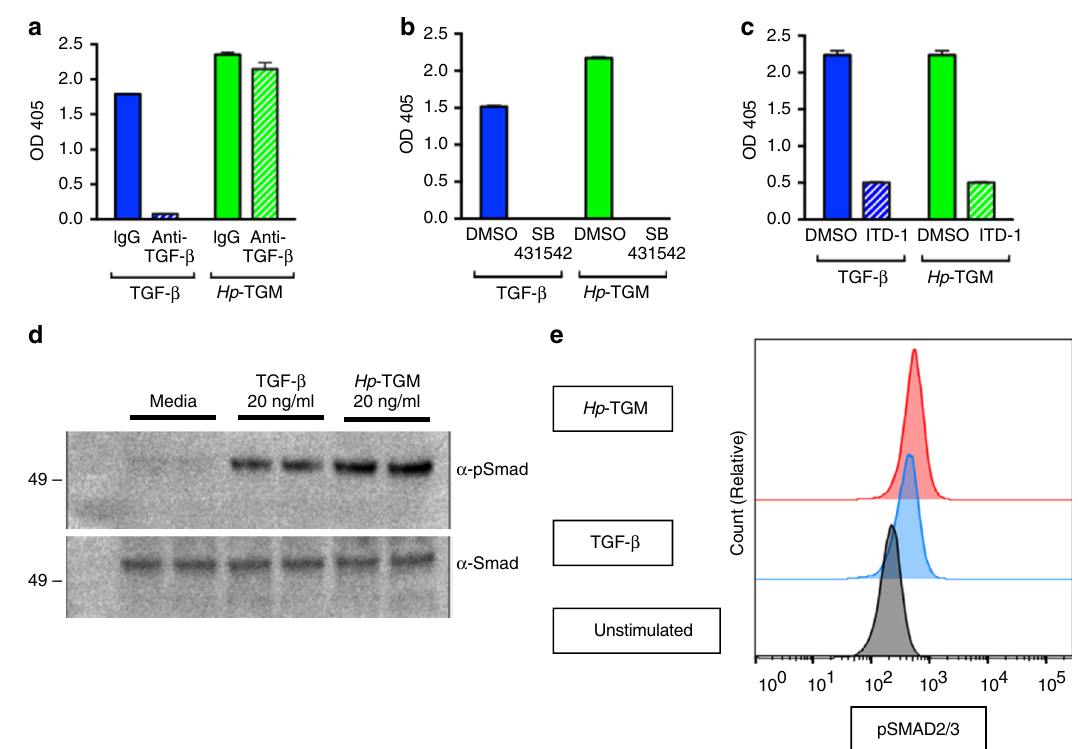
Fig. 3 Hp- TGM signals through the TGF- β pathway. a Activity shown from MFB-F11 bioassay after 24 h of culture at 37 °C with hTGF- β 1 or Hp -TGM incubated with anti-TGF- β monoclonal antibody or MOPC31C IgG control. Data shown are representative of two independent experiments, and represent mean ± SEM from duplicate wells; analysis by multiple t tests shows antibody signi fi cantly reduces effect of TGF- β ( P < 0.0001), but has no signi fi cant effect on TGM. b , c Abolition of signaling by inhibitors of the TGF- β receptor kinases. Activity shown from MFB-F11 bioassay after 24 h of culture of TGF- β and Hp- TGM at 37 °C with: b the T β RI inhibitor, SB431542 or DMSO control and c the T β RII inhibitor, ITD-1 (10 µ M). Data shown are representative of ≥ 2 independent experiments, and represent mean ± SEM from duplicate wells. Analysis by multiple t tests shows that effects of both mediators are signi fi cantly reduced by SB431542 ( p < 0.0001) and ITD-1 ( P < 0.001). d Western blots (Smad2 and phospho-Smad2): cell lysates from C57BL/ 6 splenocytes following culture at 37 °C for 18 h. Culture conditions in duplicate: media (DMEM + 2.5% FCS), media supplementted with 20 ng/ml hTGF- β 1 and media supplemented with 20 ng/ml Hp- TGM. Position of a 49-kDa marker protein detected by negative staining is marked on each blot. e Phospho- Flow analysis with anti-phospho-Smad2/3 on murine CD4 + T cells stimulated for 16 h with 20 ng/ml of Hp- TGM or hTGF- β 1, before permeabilization and staining with speci fi c antibody. A representative individual histogram is